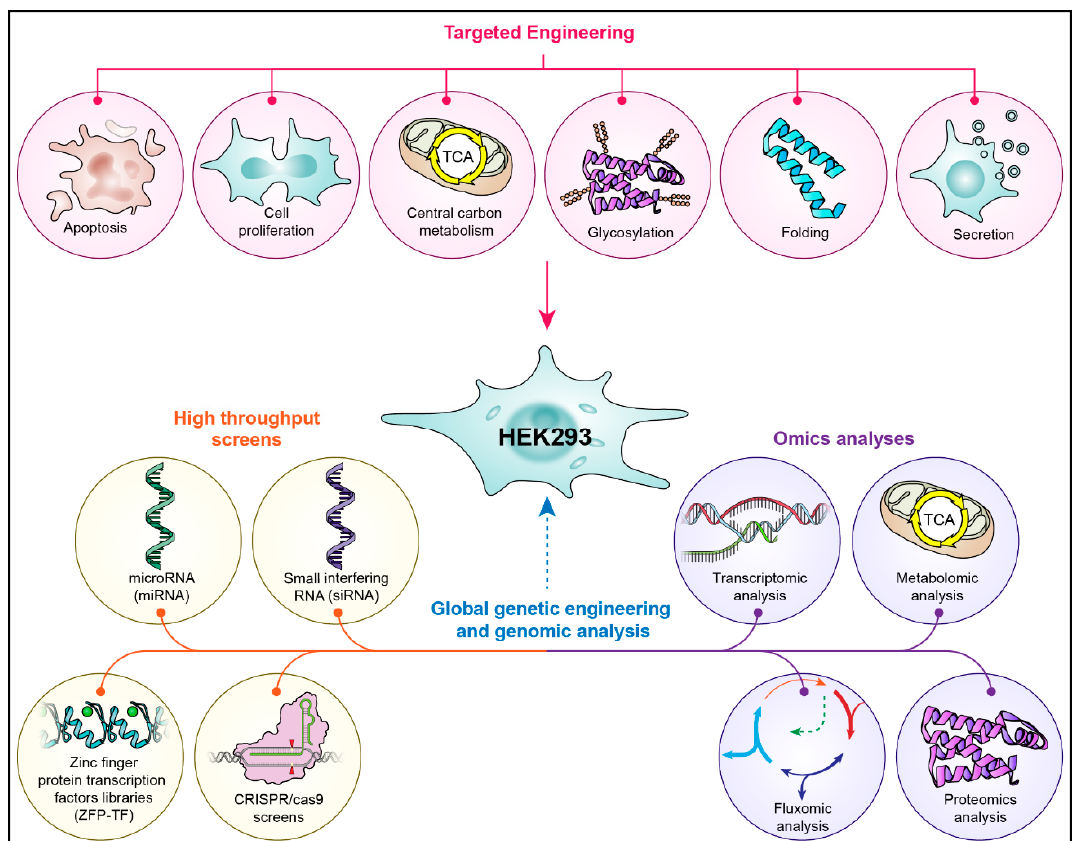
Figure 1. Engineering the HEK293 cell line for improved culture performance. In targeted engineering, genes involved in processes directly affecting protein expression such as apoptosis, cell proliferation, central carbon metabolism, glycosylation, protein folding, and secretion are modified. Global engineering encompasses high throughput screens using RNA interference (miRNA and siRNA), Zinc Finger protein transcription factor libraries, and CRISPR/Cas 9 libraries, and omics analysis such as transcriptomic, proteomic, metabolomic, and fluxomic analyses that are utilized to discover novel engineering targets.